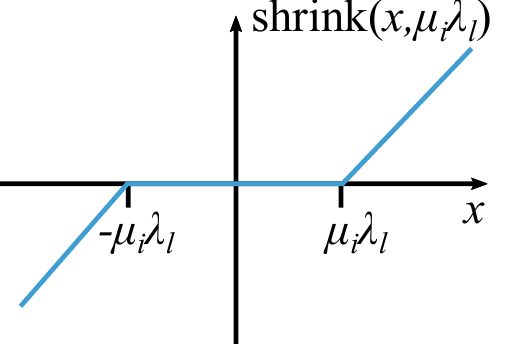
Figure 1. Graphic representation of the shrink